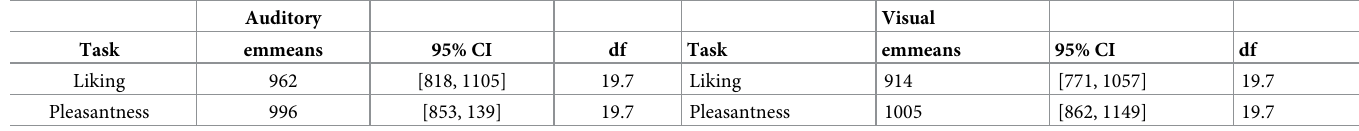
The table entails the estimated marginal means for each task in the corresponding